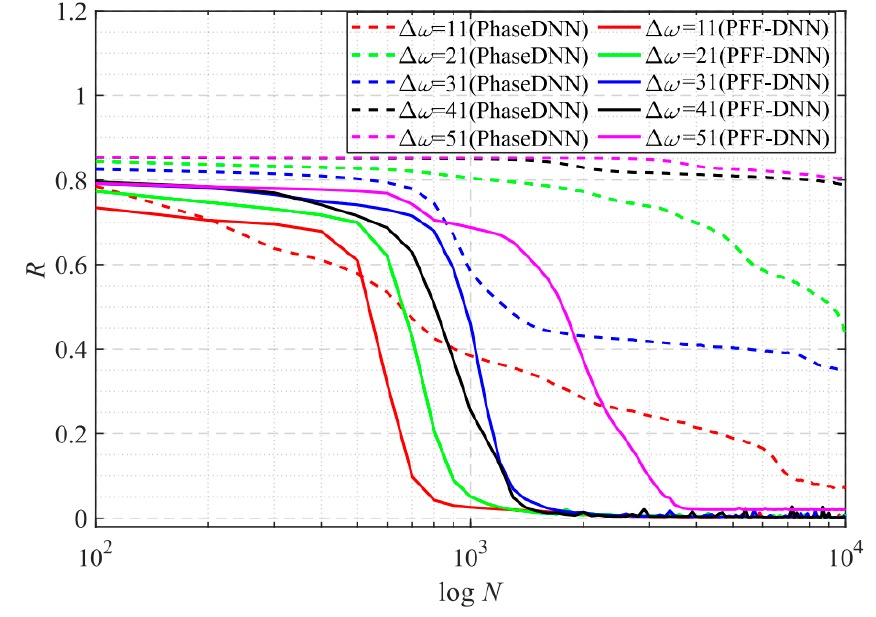
Figure 6. The influence of Δ ω on the convergence process.